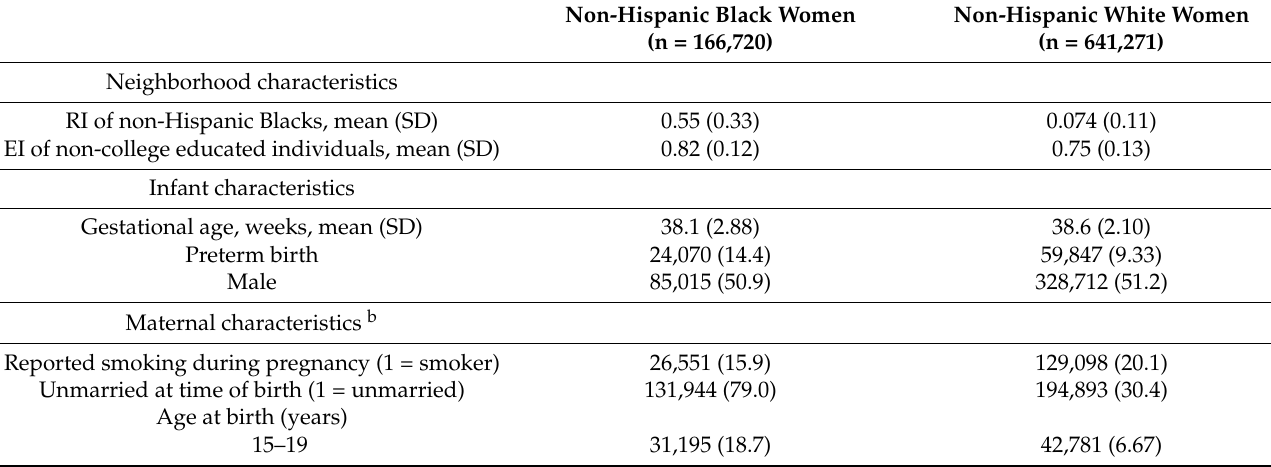
Table 1. Summary statistics of the Michigan births analysis dataset a